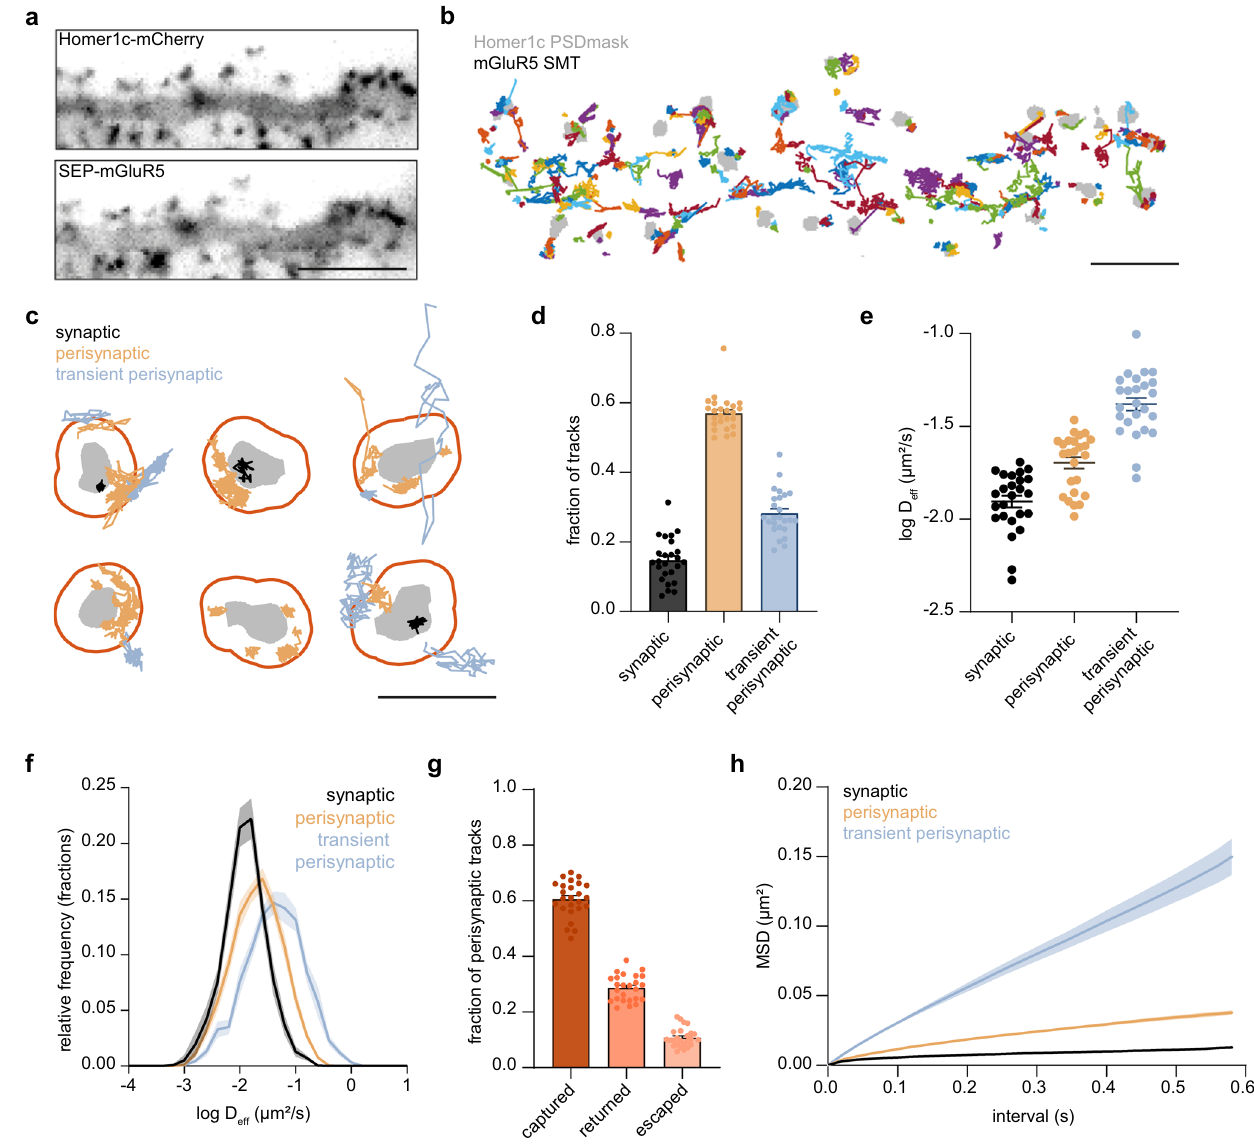
Fig.3|DistributionofmGluR5diffusioninspinesisheterogeneous.a Wide fi eld of dendrite expressing Homer1c-mCherry and SEP-mGluR5. Scale bar, 5 µ m. b Single-molecule trajectories (SMTs) of mGluR5 (each trajectory is assigned a random color) relative to the Homer1c PSD mask (gray) in the same dendrite as shown in a. Scale bar, 2 µ m. c Example PSDs (gray) with their perisynaptic zone (orange ring) and mGluR5 SMTs color-coded for their subsynaptic localization. Scale bar, 1 µ m. d Fraction of synaptic, perisynaptic, and transient perisynaptic mGluR5 SMTs ( n =25 neurons). e Mean log D eff per neuron of synaptic, perisy- naptic, and transient perisynaptic mGluR5 SMTs ( n =25 neurons). f Relative